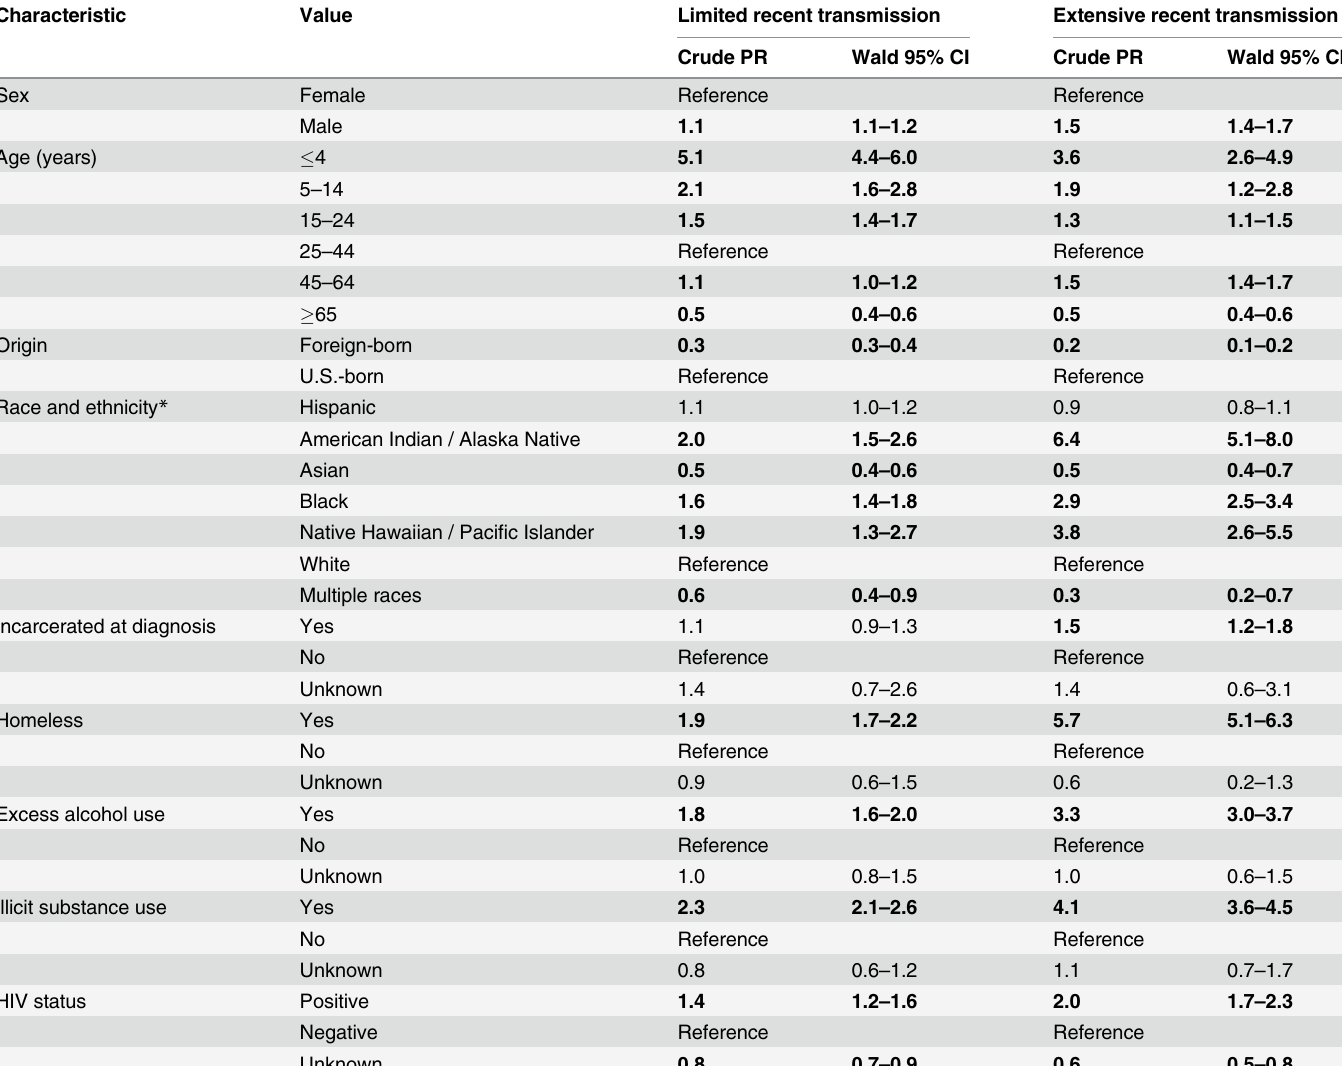
Table 2. Bivariate associations between patient characteristics and recent transmission.